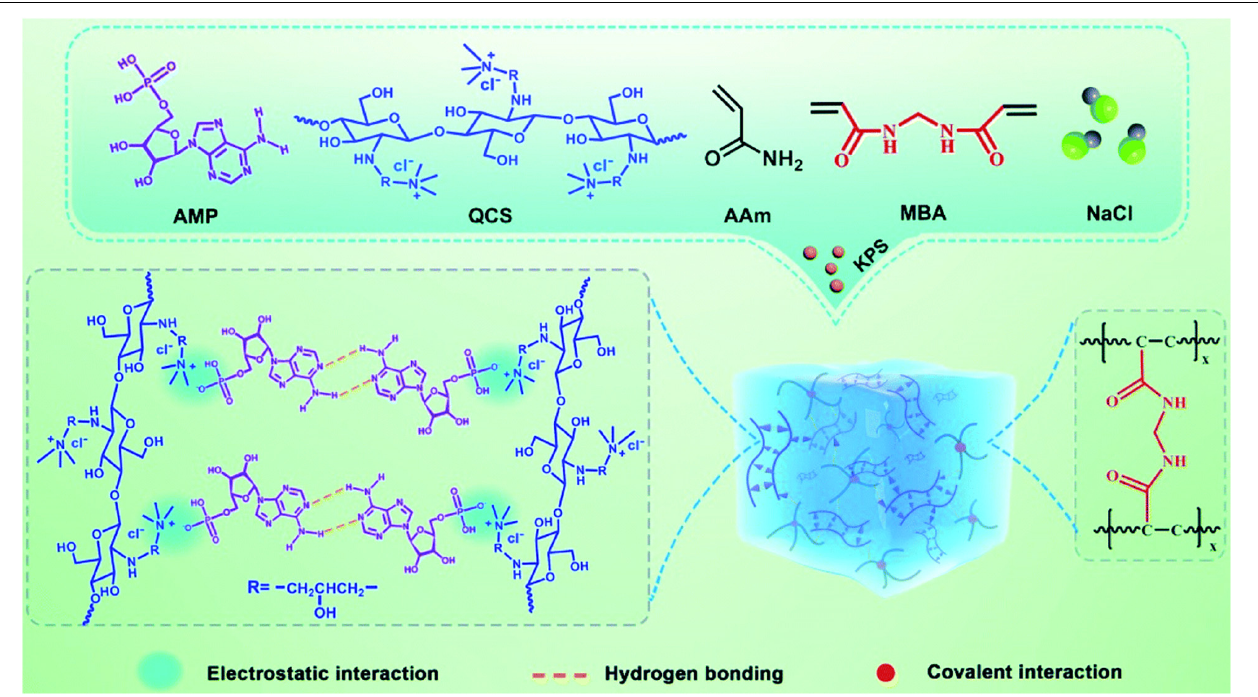
FIGURE 5 | Schematic diagram of the preparation of DNA-inspired hydrogel mechanoreceptor. Reprinted with permission from Zhang et al. (2021). Copyright (2021) The Royal Society of